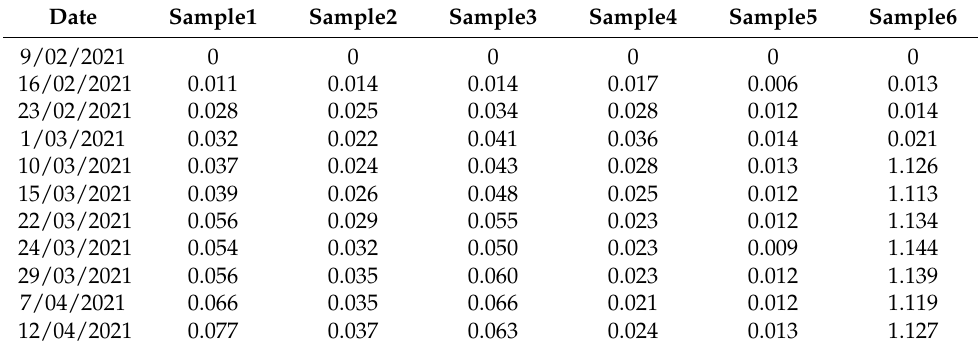
Table A3. Predicted relative NOx concentration using the SVR model.